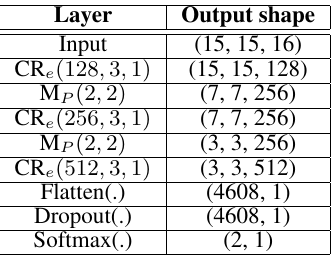
Table 3. CycleGAN discriminator architecture.